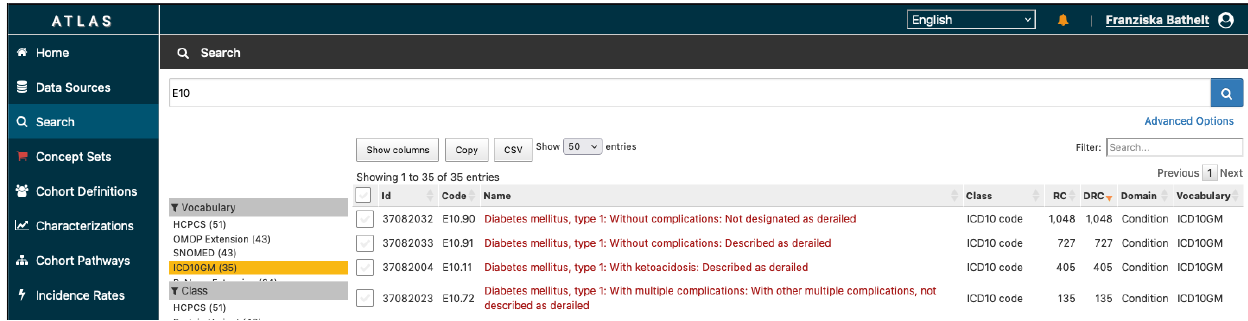
Figure A2. Interface of OHDSI ATLAS—Vocabulary selection.